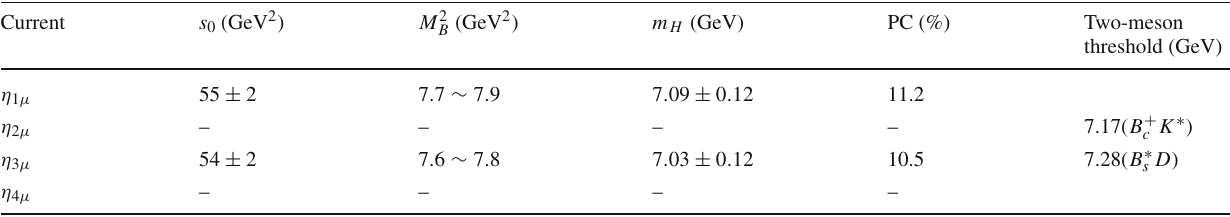
Table 4 The continuum threshold, Borel window, mass and pole contribution for the sc ¯ q ¯ b system with J P = 1 +